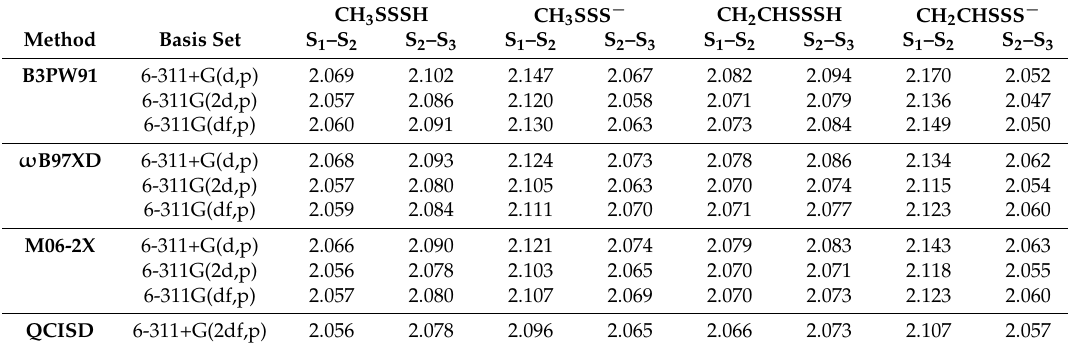
Table 4. Selected optimized bond lengths (in ångstroms; Å) for RSSSH (R = CH 3 , CH 2